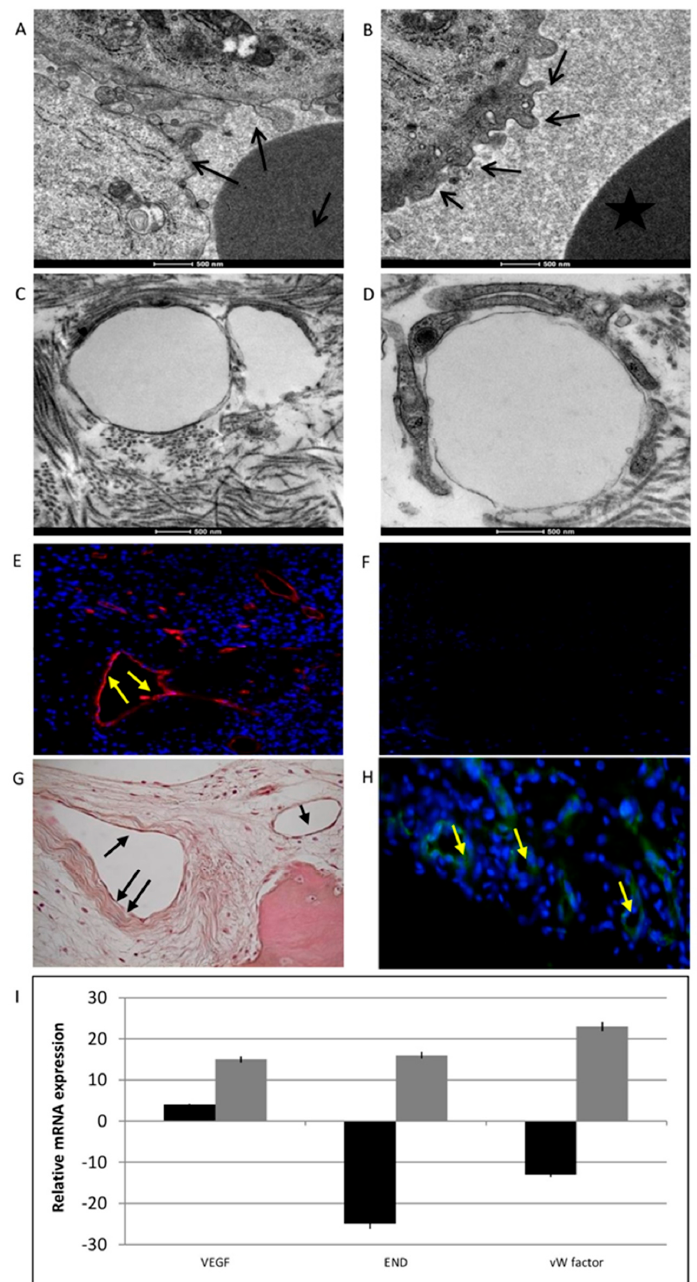
Figure 9. Analyses of vascularization process. ( A , B ) TEM analyses of peri-implantitis affected tissues showing endothelial cells with irregular membranes and abnormal bubbles (black arrows). ( C , D ) TEM analyses of endothelial cells in control samples. ( E ) Immunofluorescence staining of VWF (red) and nuclei (blue) in peri-implantitis affected tissue and in control ( G ). ( F ) Immunofluorescence against CD31. No signal indicates the absence of mature endothelial cells in peri-implantitis affected tissue and in control ( H ) No signal confirms the absence of mature endothelial cells. ( I ) Gene expression analyses of the markers related to vascularization: VEGFA, ENG, and VWF. Black bars peri-implantitis affected tissue, grey bars control, results are related to the up-regulation or down-regulation comapre to the house keeping. T-tests were used to determine significant di ff erences ( p < 0.05). * p < 0.05; ** p < 0.01; *** p <